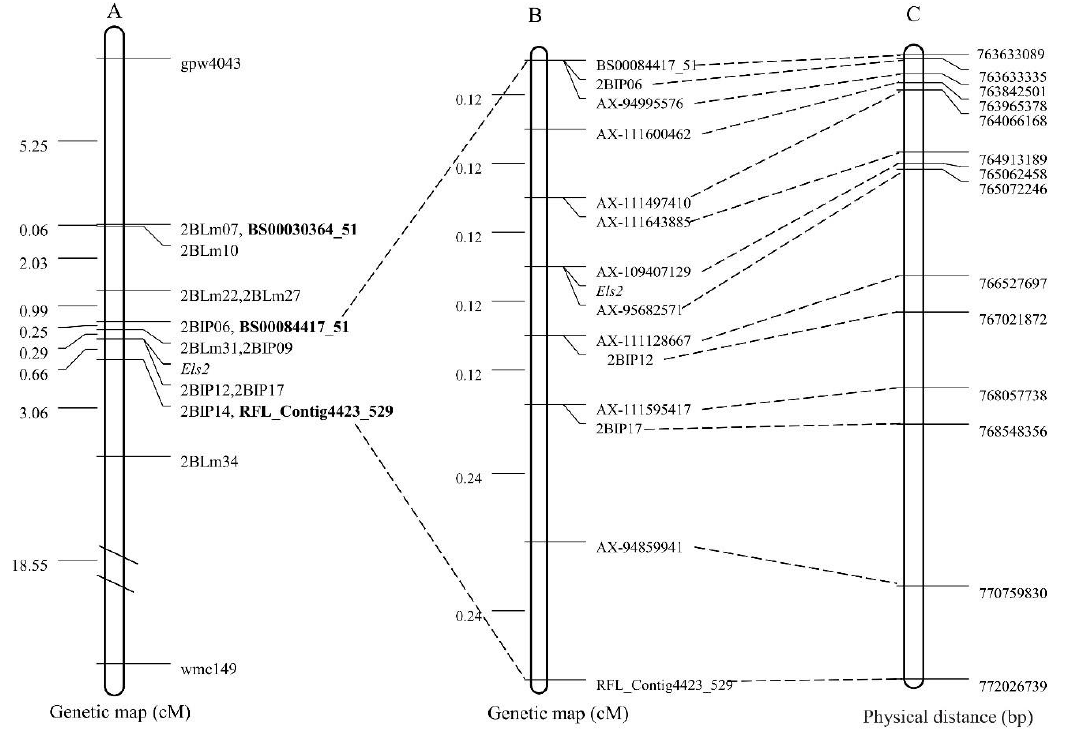
Figure 2. The genetic linkage map and physical map of Chinese Spring genomic sequence fanking the Els2 gene. ( A ) The preliminary genetic linkage map of the Els2 gene [49]. ( B ) The high-resolution genetic map of the Els2 gene. ( C ) The corresponding physical location of the polymorphic linkage markers of the Els2 gene. Table 1. Primer sequences of Kompetitive allele-specific polymerase (KASP) markers developed from the 90K and 660K arrays.